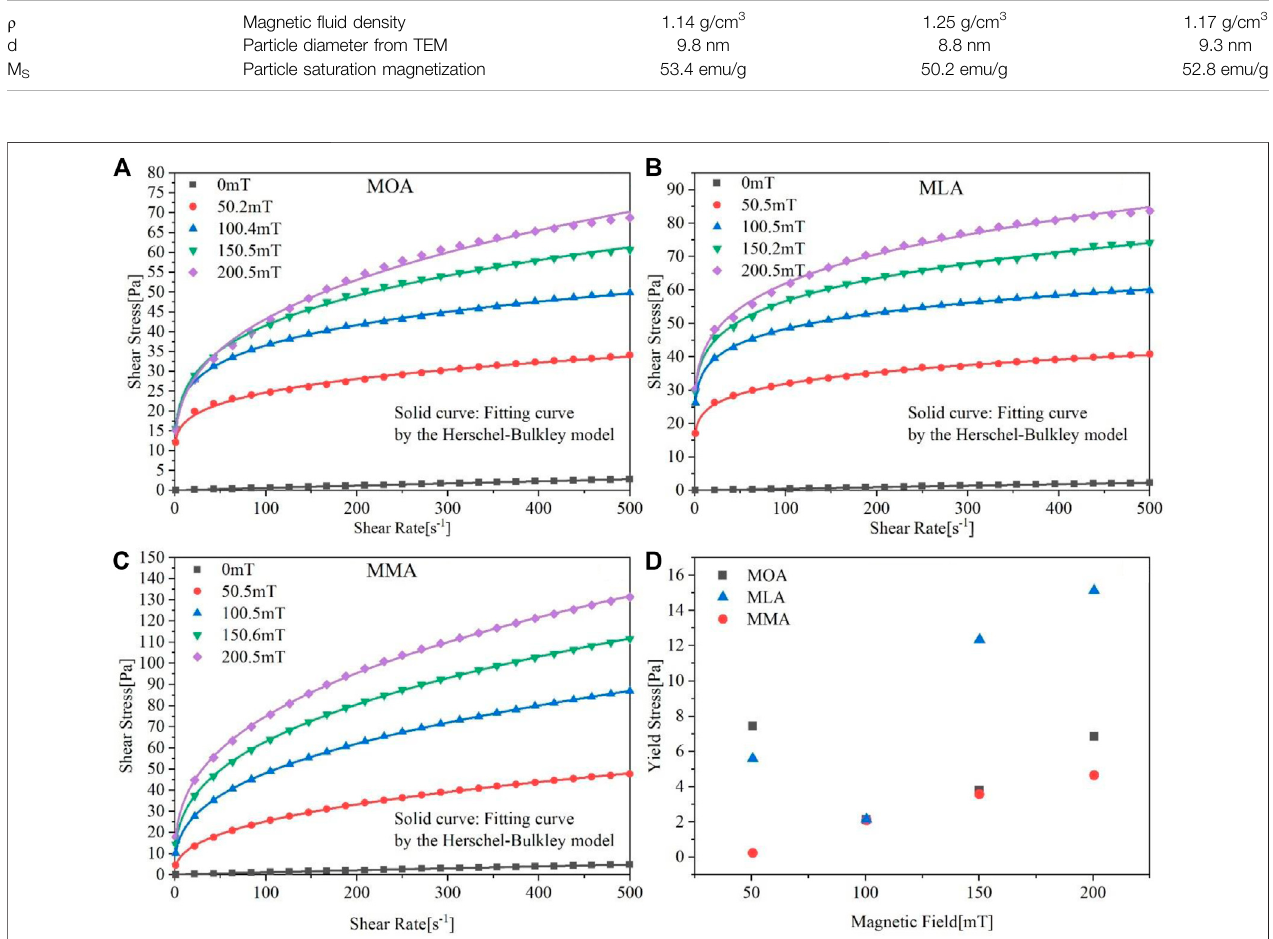
FIGURE 6| Stress-strain images of (A) MOA, (B) MLA, and (C) MMA. (D) Fitted yield stress values of three magnetic fl uids bythe Herschel – Bulkley model under a constant magnetic fi eld.